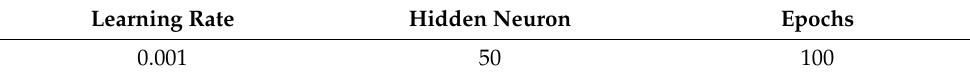
Table 1. Parameters in the LSTM